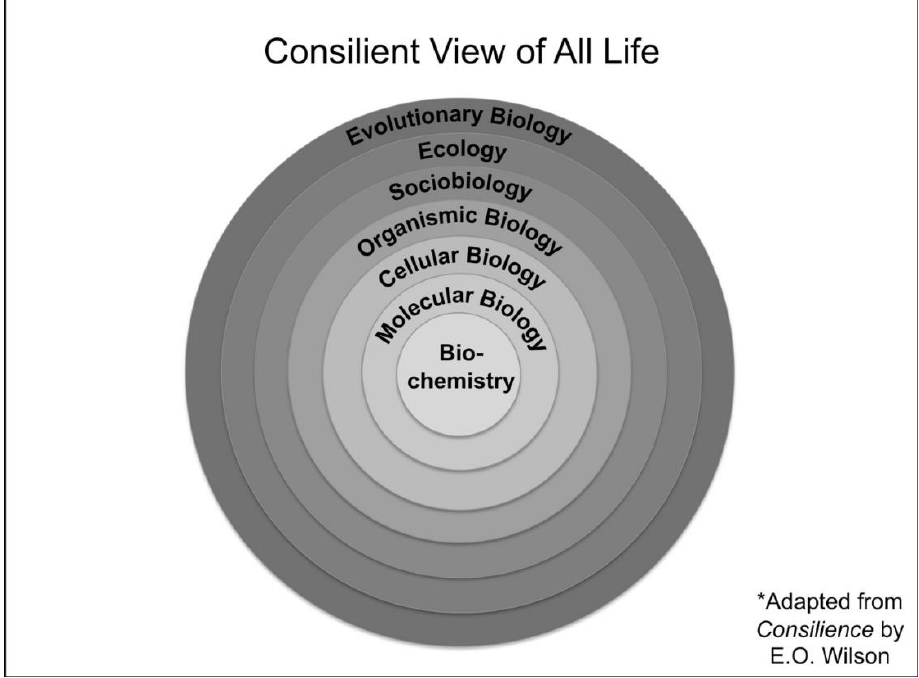
Figure 1: Seven Spheres of Biology (Adapted from Wilson